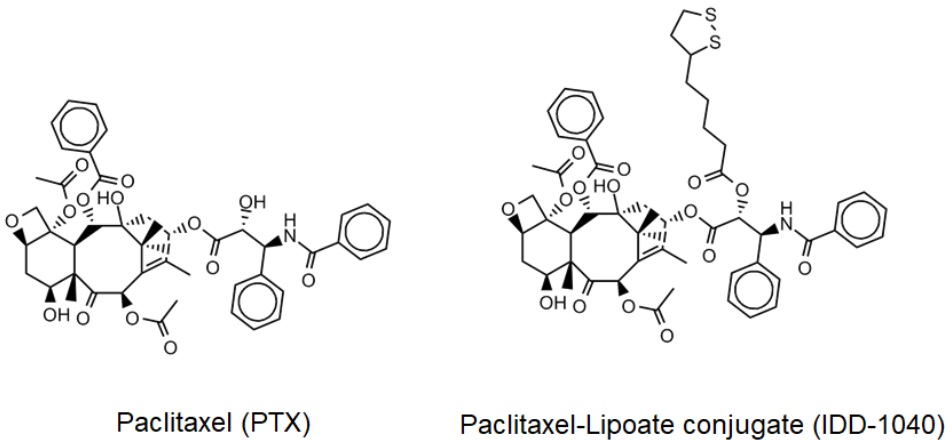
Figure 1. The chemical structure of paclitaxel (left side), and IDD-1040 (right side).